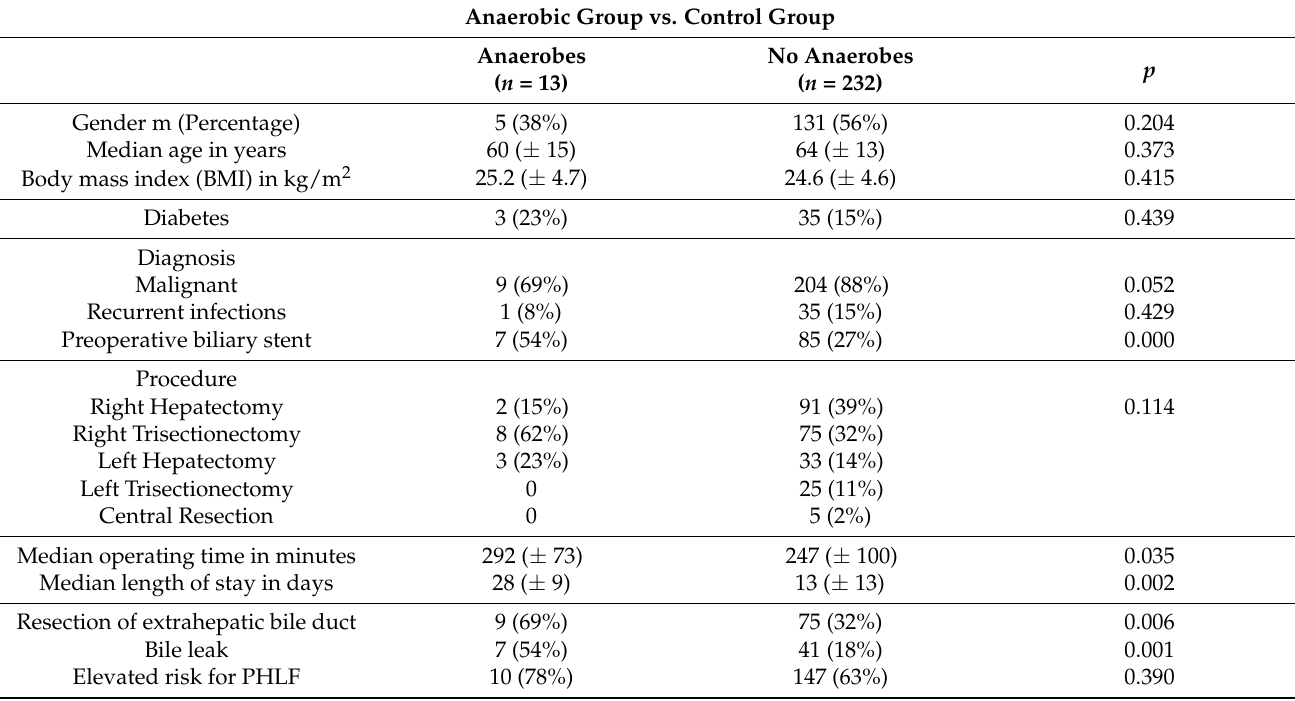
Table 2. The comparison of the group of patients that grew anaerobic bacteria and the control group that did not. Anaerobic Group vs. Control